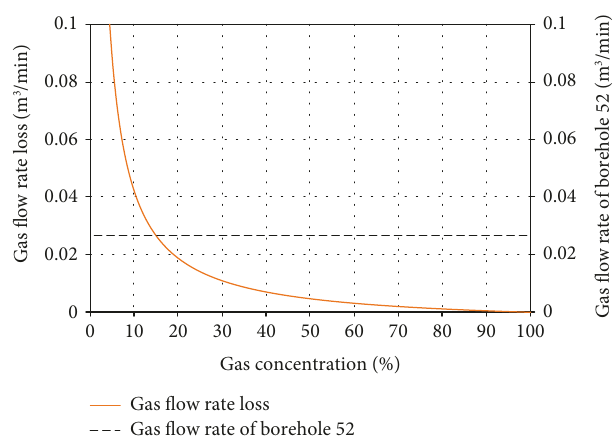
Figure 6: Curves of gas fl ow loss caused by air leakage through the 52nd group of boreholes under di ff erent concentrations.